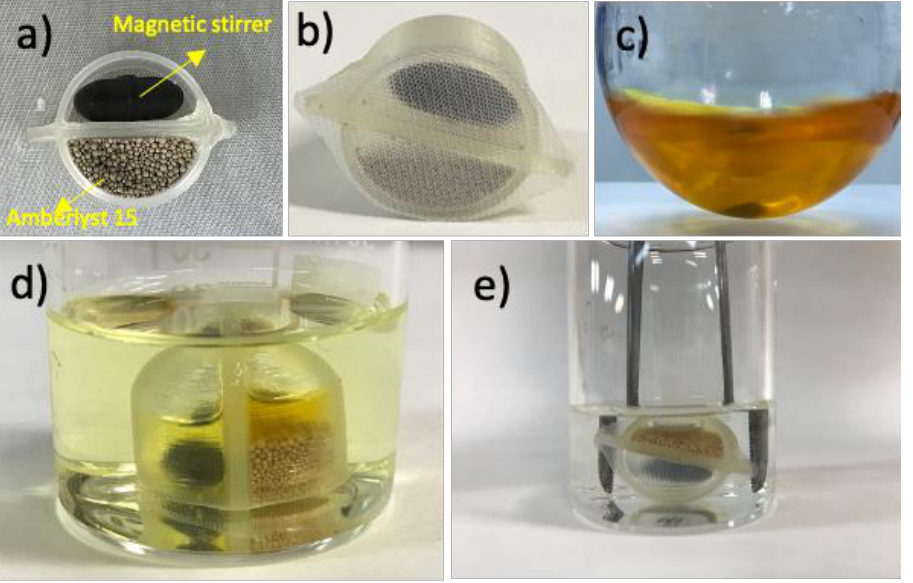
Figure 4. ( a ) Parietal view of the compartments during the 3D-printing process of capsule@Amberlyst-15 and the magnetic stirrer. ( b ) Bicompartimental 3D-printed Capsule@Amberlyst-15 finished, before scavenging. ( c ) Reaction mixture during treatment with Capsule@Amberlyst-15 polypropylene capsule. ( d ) Washing of the capsule after scavenging. ( e ) Capsule after TFA/DCM treatment, 1 h.